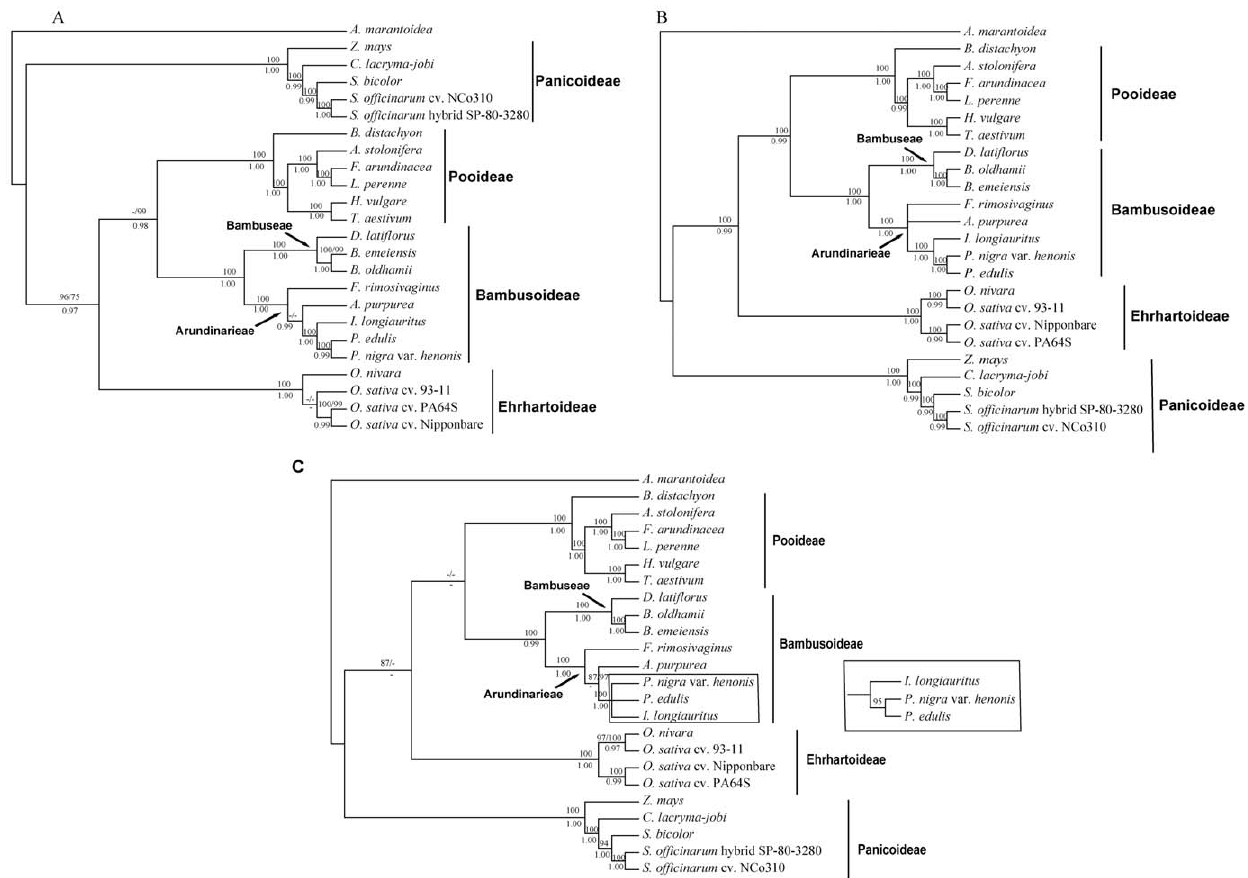
Figure 6. Maximum parsimony phylogram of 24 Poaceae accessions as determined from different data partitions. A ) 74 Protein coding genes. B ) Large single copy (LSC) region. C ) Small single copy (SSC) region. Numbers above nodes are maximum parsimony bootstrap/ maximum likelihood bootstrap support values and only one number is shown if the two values are equal. Numbers below nodes are Bayesian inference posterior probability. The inset box in the lower right indicates topological difference form maximum likelihood and Bayesian analysis.